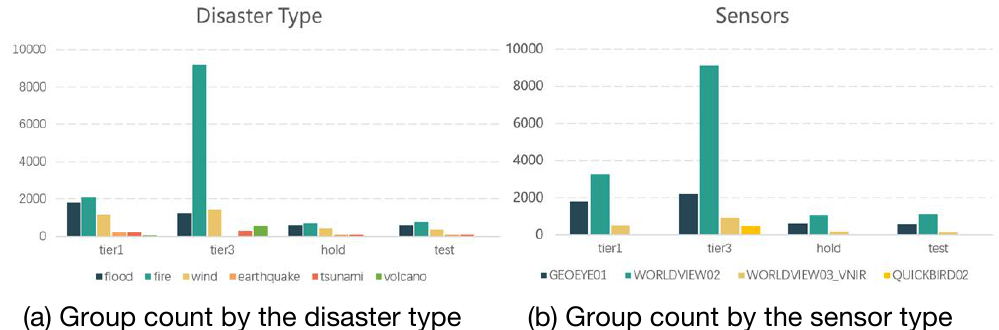
Figure 3. Histogram of ( a ) different disaster types and ( b ) different sensors images are obtained by in tier 1, tier 3, tier hold and tier test for xBD dataset. The distribution demonstrates the unbalanced distribution both in disaster types and sensor types in the dataset.